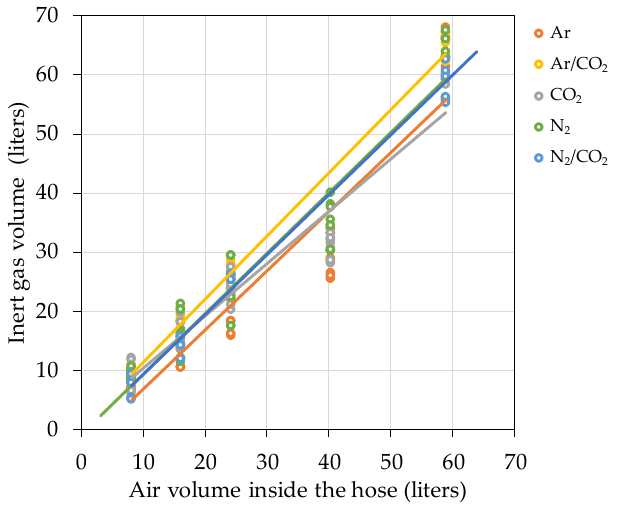
Figure 11. Inert gas volume consumed to reach a complete purge of the air volume inside the IIR hoses with CO 2 , Ar, N 2 /CO 2 , N 2 and Ar/CO 2 .